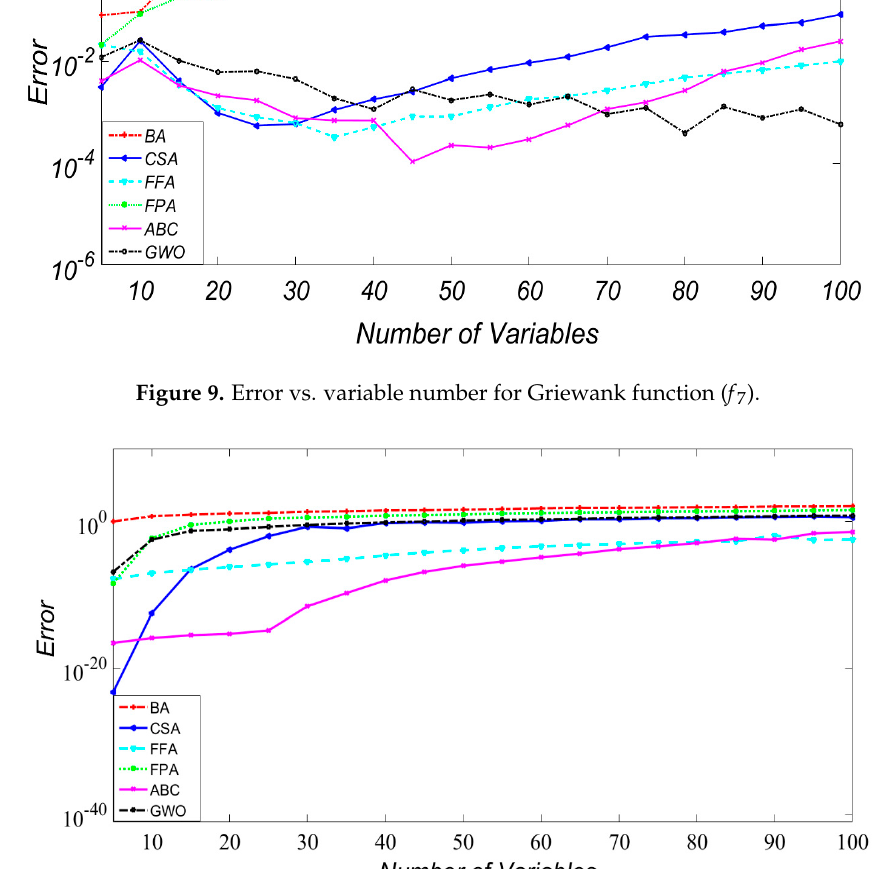
Figure 10. Error vs. variable number for Dixon and Price function ( f 13 ).